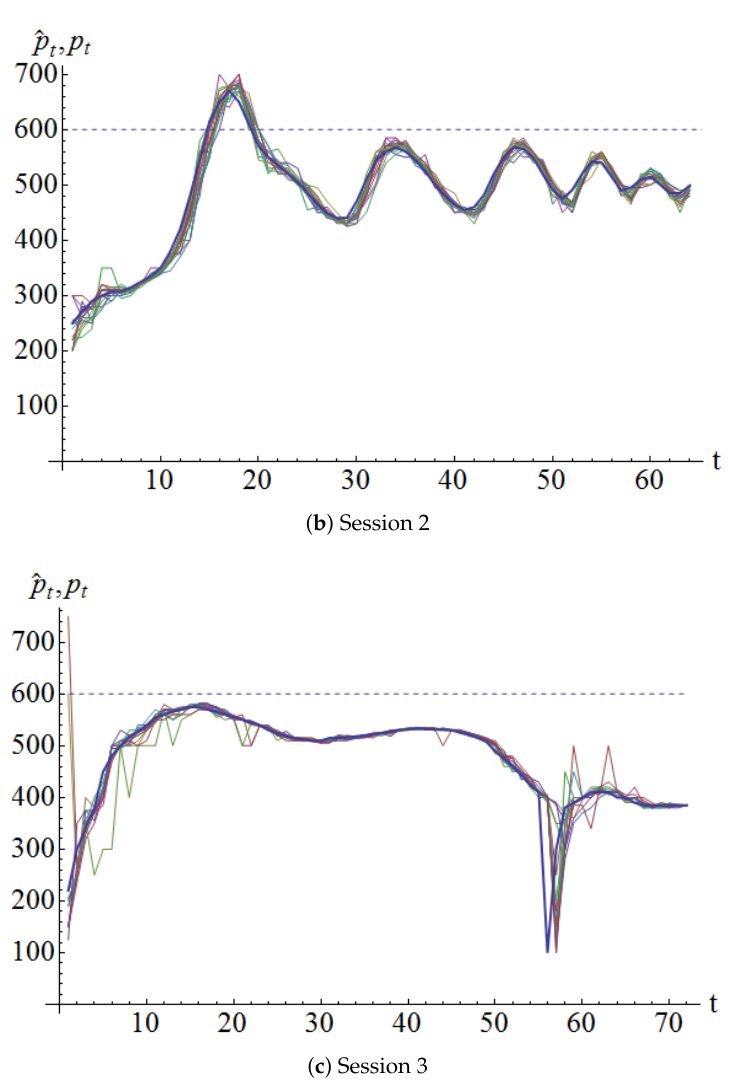
Figure 2. Price forecasts for each period from Sessions 1–3 (Sub-figures ( a )–( c )